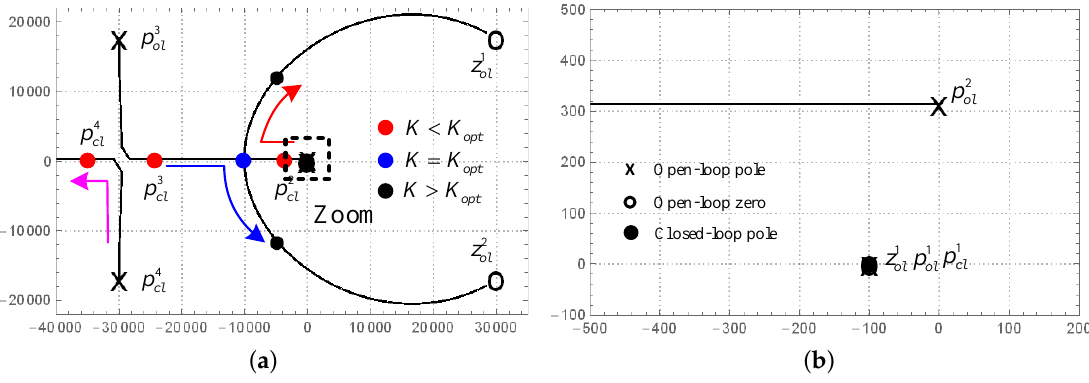
Figure 10. Root locus of current loop based on D-PCI controller: ( a ) general view; and ( b ) closer view of the dotted line